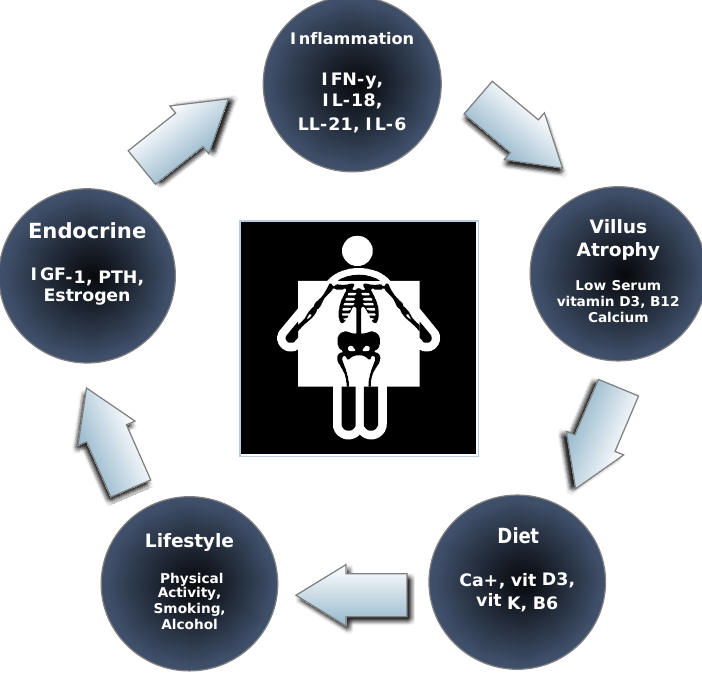
Figure 2. Dysfunctional bone metabolism in celiac disease.